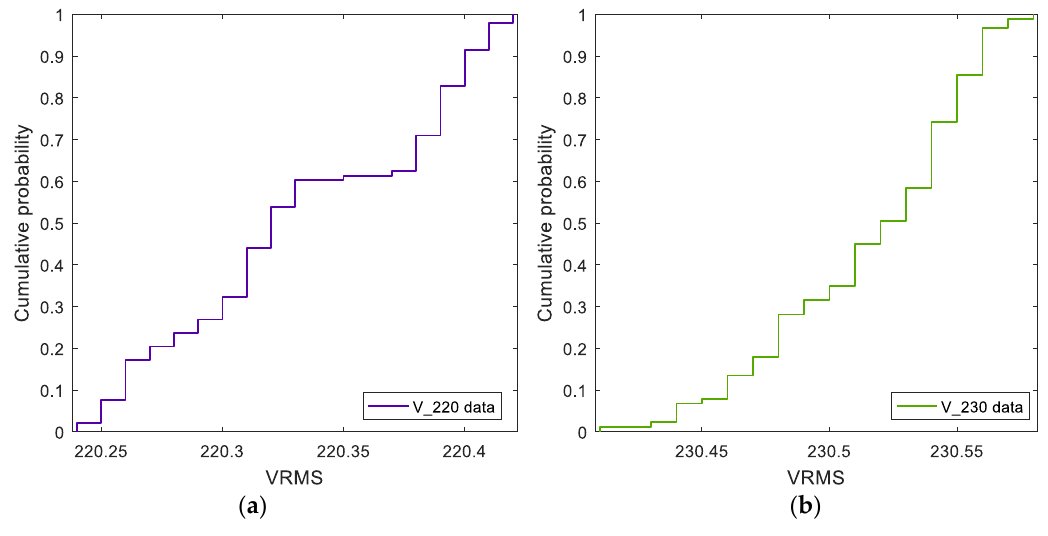
Figure 16. Cumulative distribution function of registered values with 220 ( a ) and 230 V ( b ).